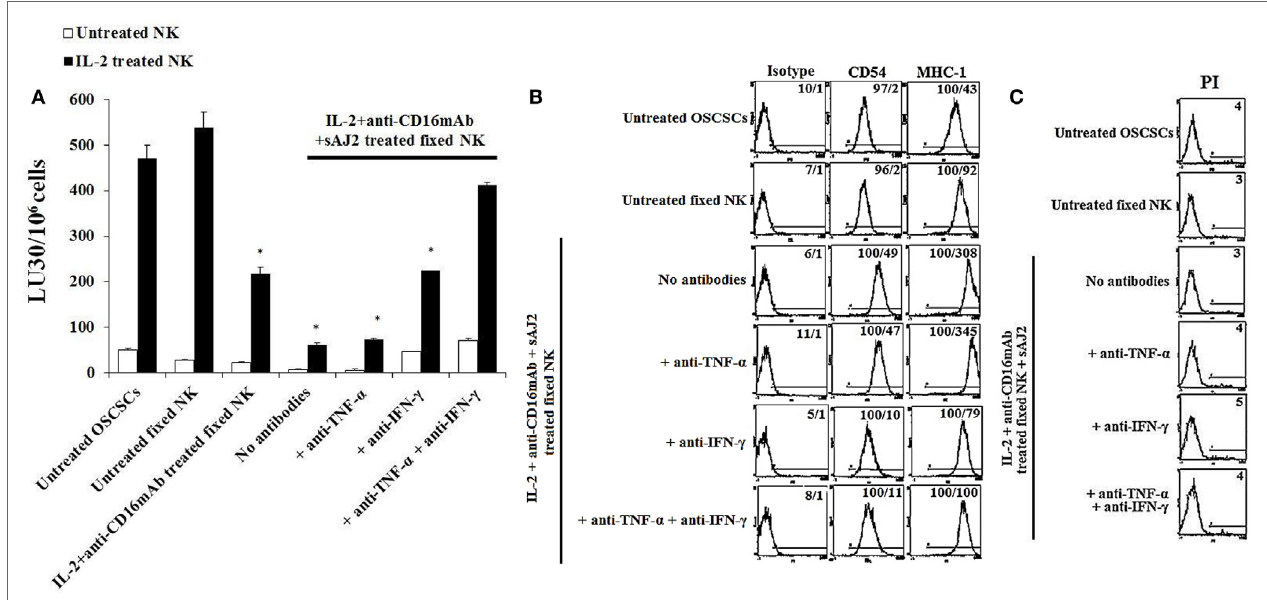
FigUre 3 | Paraformaldehyde fixed il-2 + anti-cD16 mab + saJ2-treated nK cells mediated differentiation and resistance of Oscscs against nK cell-mediated cytotoxicity . NK cells were left untreated or treated with a combination or IL-2 (1,000 U/mL) and anti-CD16mAb (3 μ g/mL) and sAJ2 at 1:3 (NK:sAJ2) ratio in the presence of anti-TNF- α (1:100), anti-IFN- γ (1:100), or combination of anti-TNF- α (1:100) and anti-IFN- γ (1:100) for 18 h. Afterwards, supernatants were removed, and the NK cells were fixed with freshly prepared 2% paraformaldehyde for 15 min. NK cells were then washed three times with 1 × PBS and added to tumor cultures. Differentiation of OSCSCs was conducted for 5 days with daily and gradual addition of increasing amounts of fixed NK cells. The complete removal of fixed NK cells from tumor cell cultures prior to the cytotoxicity assays was determined by microscopic assessment. Freshly isolated NK cells were left untreated or treated with IL-2 (1,000 U/mL) for 18 h before the cells were used as effector cells in 51 Cr release assay against tumor cells cultured with the NK cells. The lytic units 30/10 6 cells were determined using inverse number of NK cells required to lyse 30% of the target cells × 100. Differences between untreated OSCSCs and those stimulated with fixed IL-2 + anti-CD16mAb-treated NK or IL-2 + anti-CD16mAb-treated NK + sAJ2 with or without anti-TNF- α or anti-IFN- γ but not with the combination of anti-TNF- α and anti-IFN- γ were significant at a P -value of < 0.05 (*) (a) . OSCSCs were treated with fixed NK cells as described in (a) . The surface expressions of CD54 and MHC-1 on OSCSCs were assessed after staining with the PE-conjugated antibodies and analyzed using flow cytometry. Isotype control antibodies were used as controls. The numbers on the right hand corner are the percentages and the mean channel fluorescence intensities for each histogram (B) . NK cells were prepared as described in (a) and added to OSCSCs for 5 days. Afterwards, the tumor cells were washed with 1 × PBS, and their viability was determined using PI staining followed by flow cytometric analysis (c) . The numbers on the right hand corner are the percentages of dead cells in each